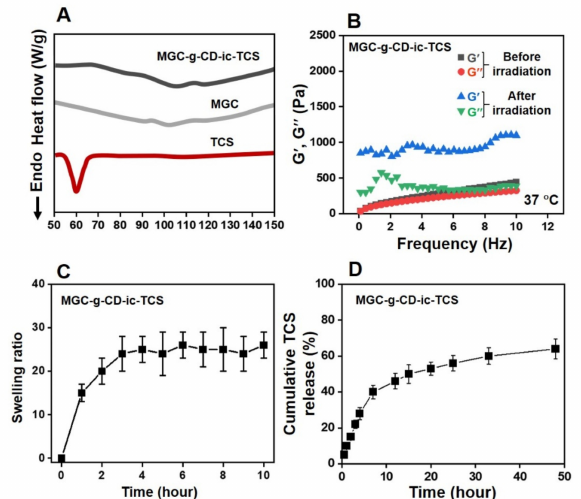
Figure 3. ( A ) DSC curves of triclosan (TCS), methacrylated glycol chitosan (MGC), and MGC-g-CD- ic-TCS monitored from 50 ◦ C to 150 ◦ C, ( B ) storage/loss moduli of MGC-g-CD-ic-TCS hydrogel precursor solution measured from 0 Hz to 10 Hz before and after visible light irradiation for 200 s, ( C ) swelling ratio of MGC-g-CD-ic-TCS measured at determined time intervals (0, 1, 2, 3, 4, 5, 6, 7, 8, 9, and 10 h), ( D ) Cumulative TCS release percentage calculated at determined time intervals (0.5, 1, 2, 3, 4, 7, 12, 15, 20, 25, 33, and 48 h). Swelling ratio and release behavior tests were performed in triplicate ( n =